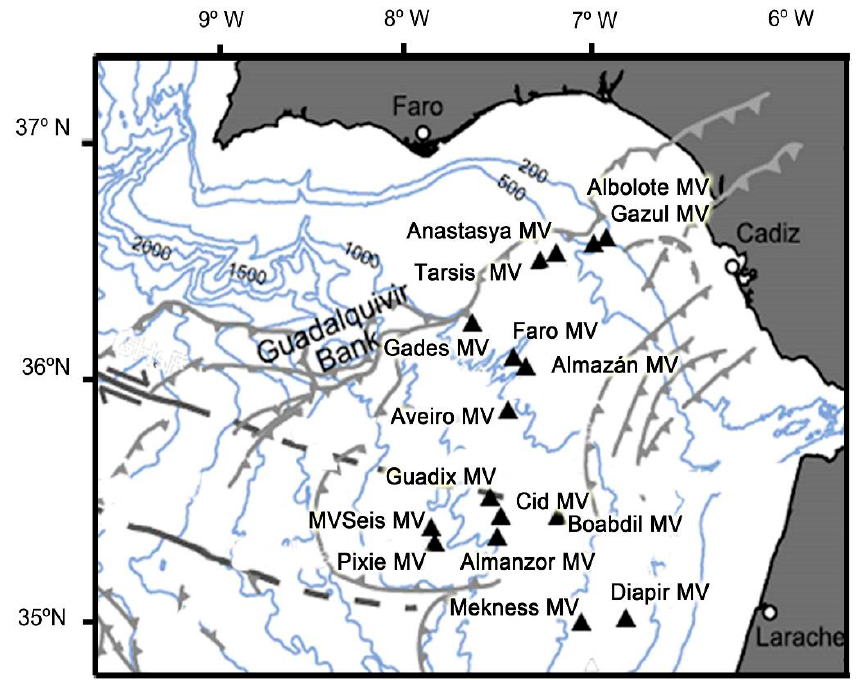
Figure 1. Structural and bathymetrical map of the Gulf of Cádiz. The MVs investigated within this study are represented by triangles. Modified from [44].